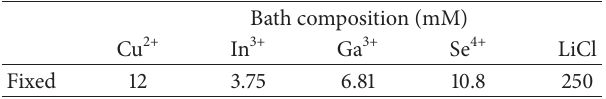
Table 1: Bath composition that used to prepare precursor CIGS thin filmsbyelectrodeposition.Allchemicalsweredissolvedinasolution of pH 2 with DI